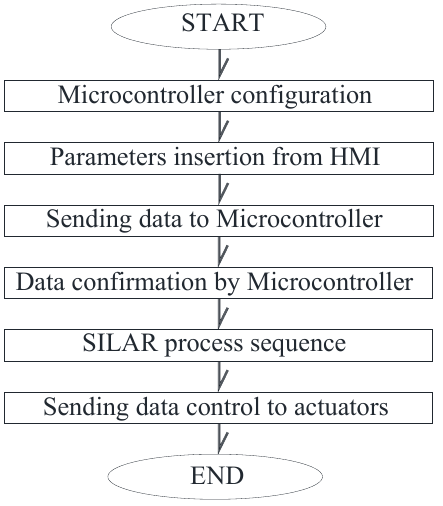
Figure 6. Flowchart for the automated SILAR prototype.